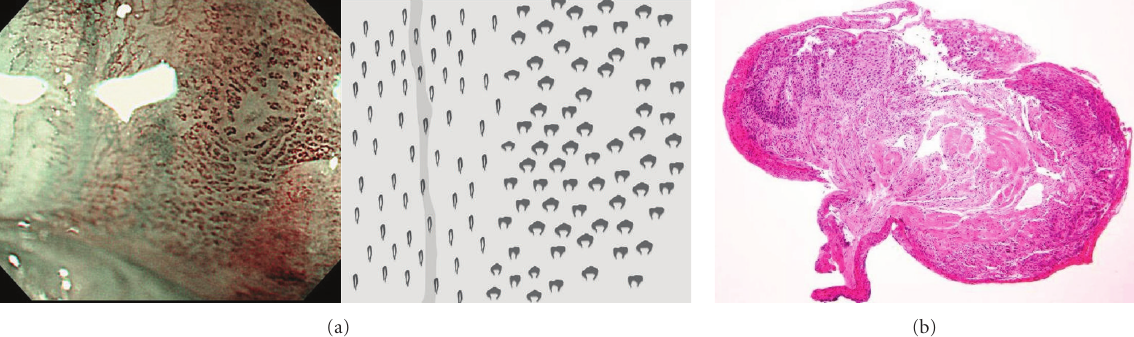
Figure 3: (a) Negative for background coloration (left panel). The color of the area between dilated IPCL is same to surrounding normal IPCL area as pointed out in schema (right image). (b) The lesion was pathologically confirmed as inflamed mucosa by biopsy.